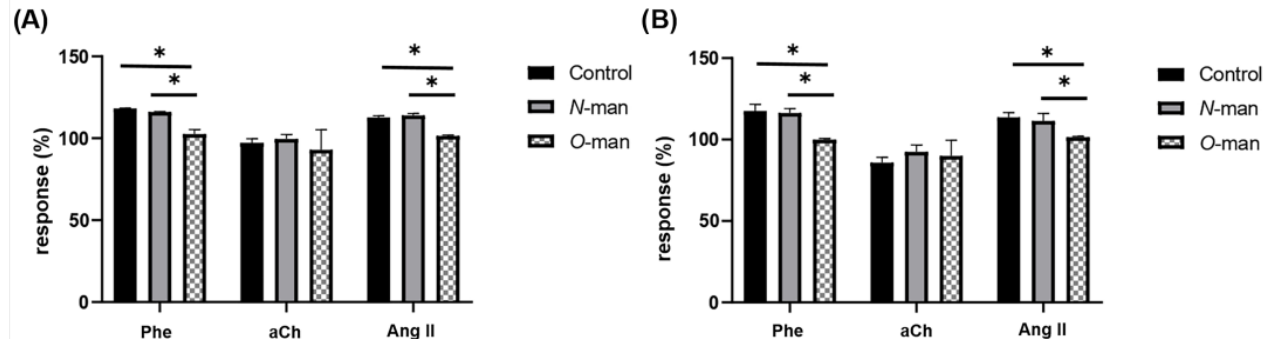
Figure 8. Modification of CPP and LVP in response to agonists when interacting isolated C. albicans mannans with coronary endothelium. Heart response, expressed as percentages of ( A ) CPP and ( B ) LVP, when Phe, aCh and Ang II are administered in the absence (Control) and in the presence of C. albicans N- linked mannans ( N -man) or C. albicans O- linked mannans ( O- man). Bars (mean SD) show the result of at least three independent experiments (* p < 0.05).